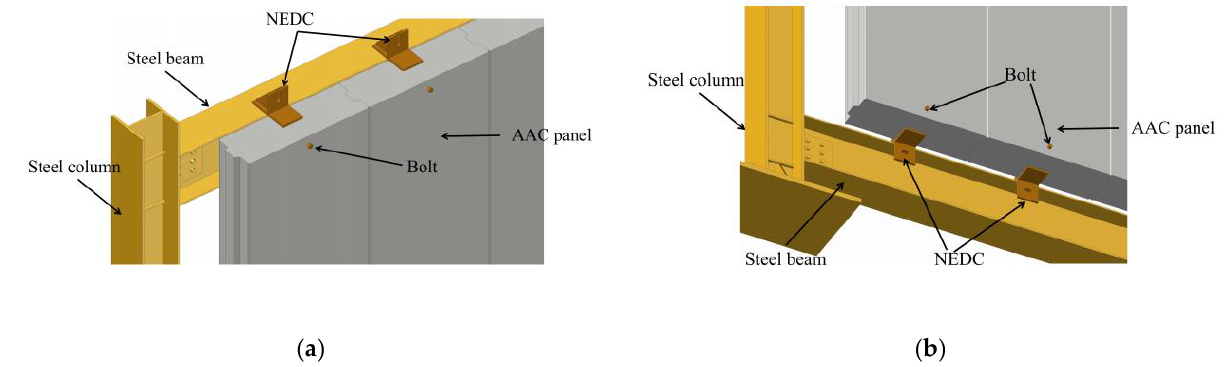
Figure 3. Schematic of the connections between NEDC and the AAC wall panel frame: ( a ) upper connection; ( b ) lower connection. An AAC wall panel must be attached to a steel beam using bolts at the top and bot- tom of the wall panel; an NEDC can connect two AAC wall panels simultaneously on the upper and lower levels, as shown in Figure 4.